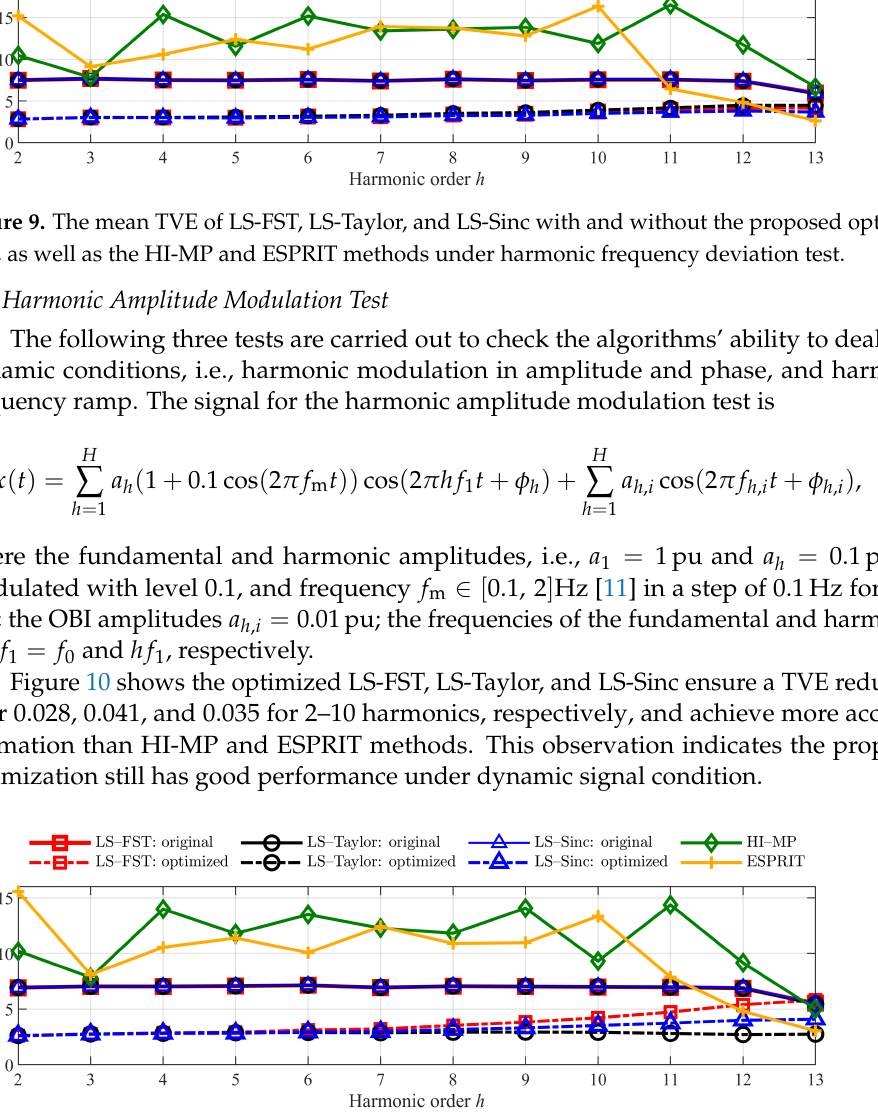
Figure 10. The mean TVE of LS-FST, LS-Taylor, and LS-Sinc with and without the proposed optimiza- tion, as well as the HI-MP and ESPRIT methods under harmonic amplitude modulation